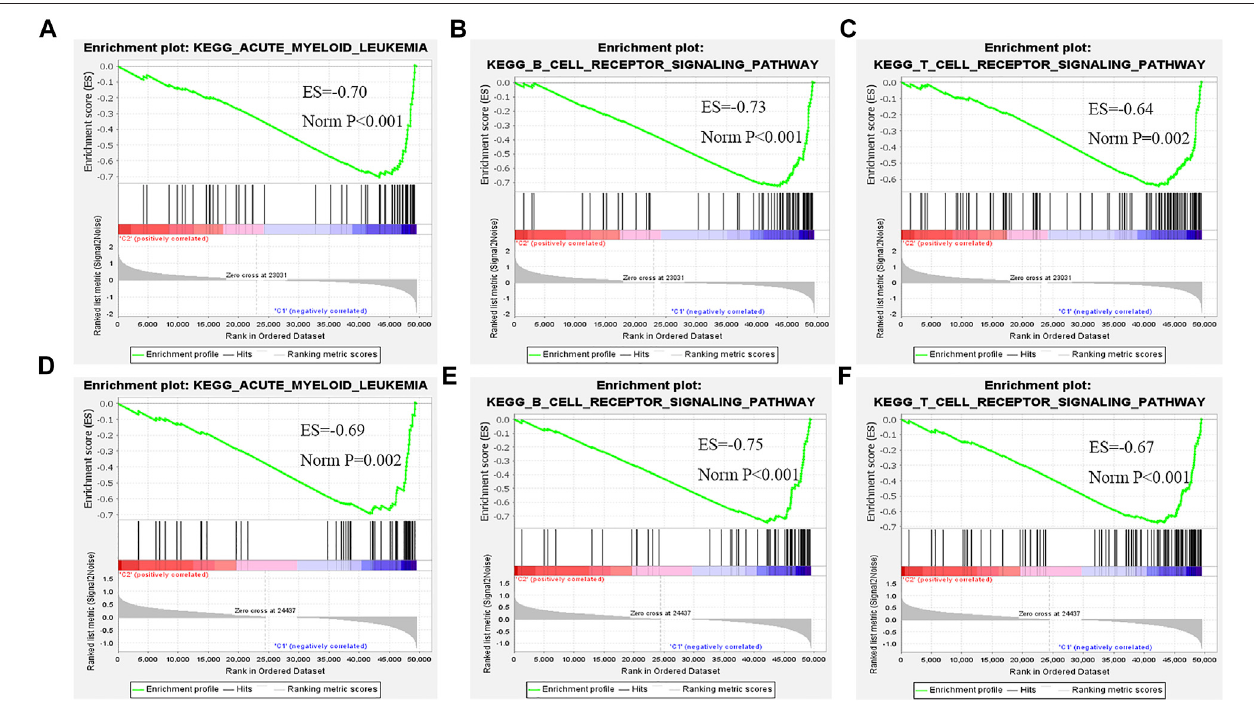
FIGURE 3 | GESA between cluster 1 and cluster 3, and cluster 2 and cluster 3. (A – C) Comparison of cluster 1 with cluster 3. GSEA-enriched partial immune signaling pathways. (D – F) Comparison of cluster 2 and cluster 3. GSEA-enriched leukemia and partial immune signaling